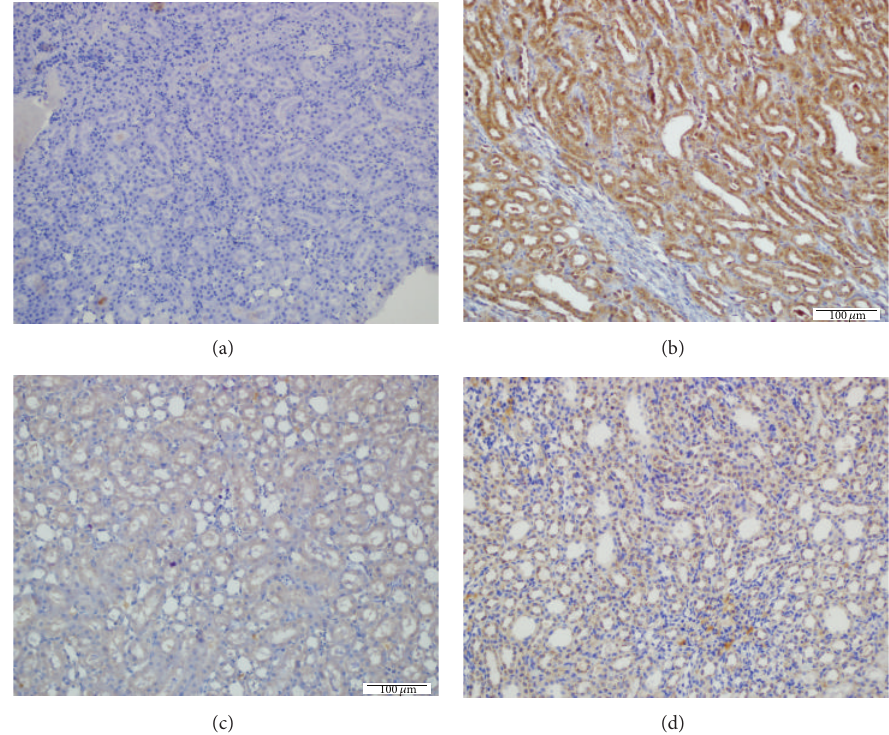
Figure 4: Evaluation of apoptosis by Bcl-2, Bax, and caspase-3 (immunohistochemical method). (a) Unusual development of immune reactivity in Control rats (IHC, × 200). (b) Immune reactivity shows increased apoptosis in the kidneys given Dichlorvos (IHK, × 200). (c) Low profile of apoptosis in the D + CAPE group (IHC, × 200). (d) The apoptosis level in the D + IL group is only lower than in the D group (IHC, ×